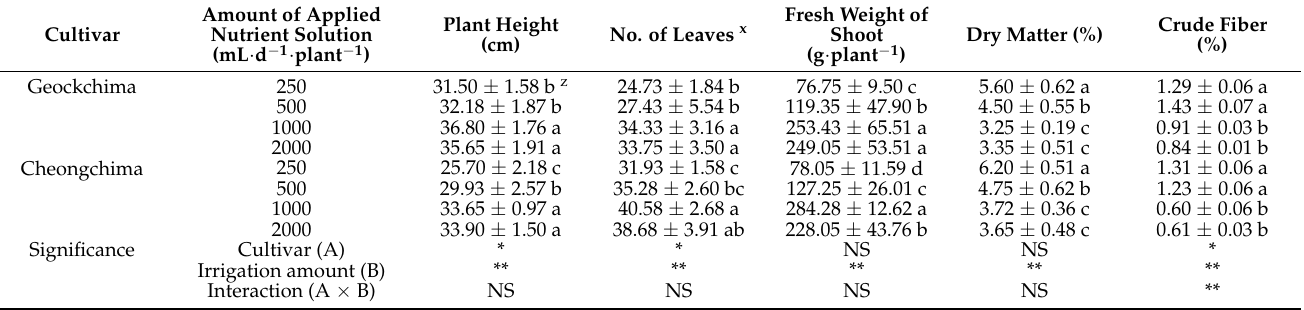
Table 1. Effects of the amount of applied nutrient solution on growth performance, dry matter, and crude fiber content of two leaf lettuce cultivars grown in perlite culture.